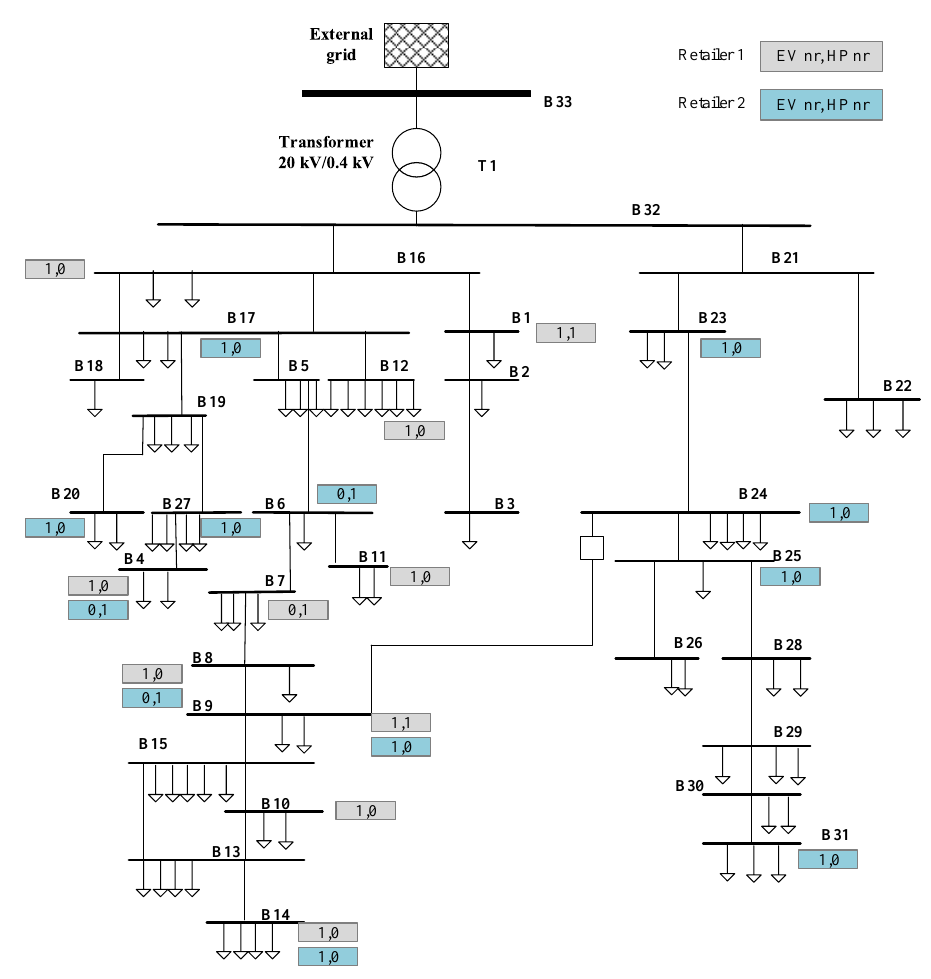
Figure 4. A representative Danish distribution network with base load, electric vehicle (EV), and heat pump (HP) connected. Gray blocks indicate Retailer 1’s EV number and HP number under each bus, and the blue blocks indicate Retailer 2’s EV number and HP number under each